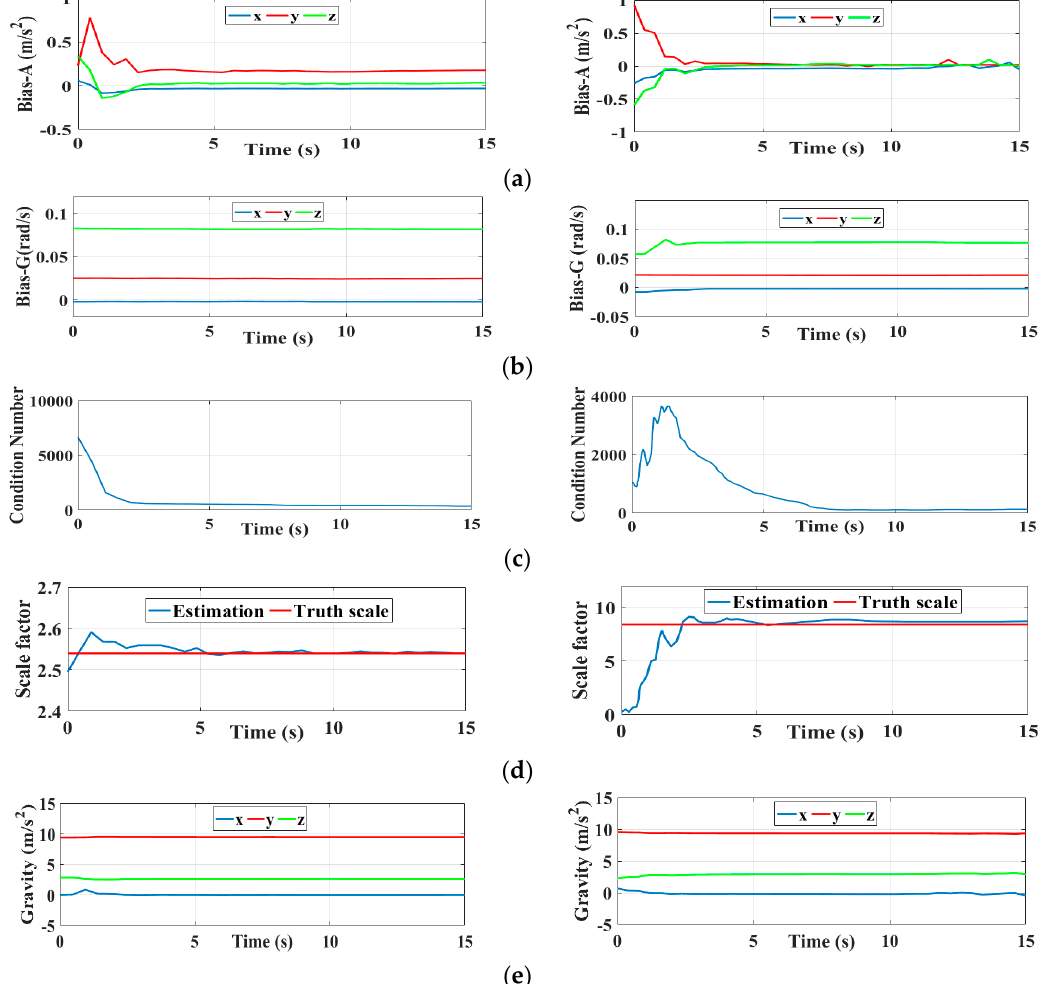
Figure 5. The convergence procedures of the initialization states for the V1_01_easy & MH_04_difficult sequences, ( a ) Initialization results of accelerometer bias; ( b ) Initialization results of gyro bias; ( c ) Calculation of the condition number; ( d ) Initialization results of scale factor; ( e ) Initialization results of gravity vector.